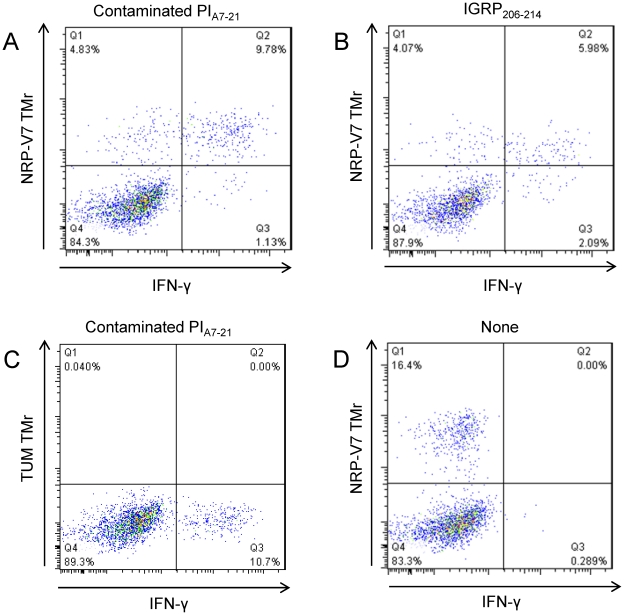
Islet-infiltrating CD8+ T-cells responding to contaminated PIA7-21 peptide are IGRP206-214-specific.Parallel IFN-γ and Kd TMr staining after stimulation with contaminated PIA7-21 or IGRP206-214 peptide. (A) Stimulation with contaminated PIA7-21 peptide and NRP-V7 Kd TMr staining. (B) Stimulation with IGRP206-214 peptide and NRP-V7 Kd TMr staining. (C) Stimulation with contaminated PIA7-21 peptide and TUM Kd TMr negative control staining. (D) Stimulation with peptide diluent alone and NRP-V7 Kd TMr staining.